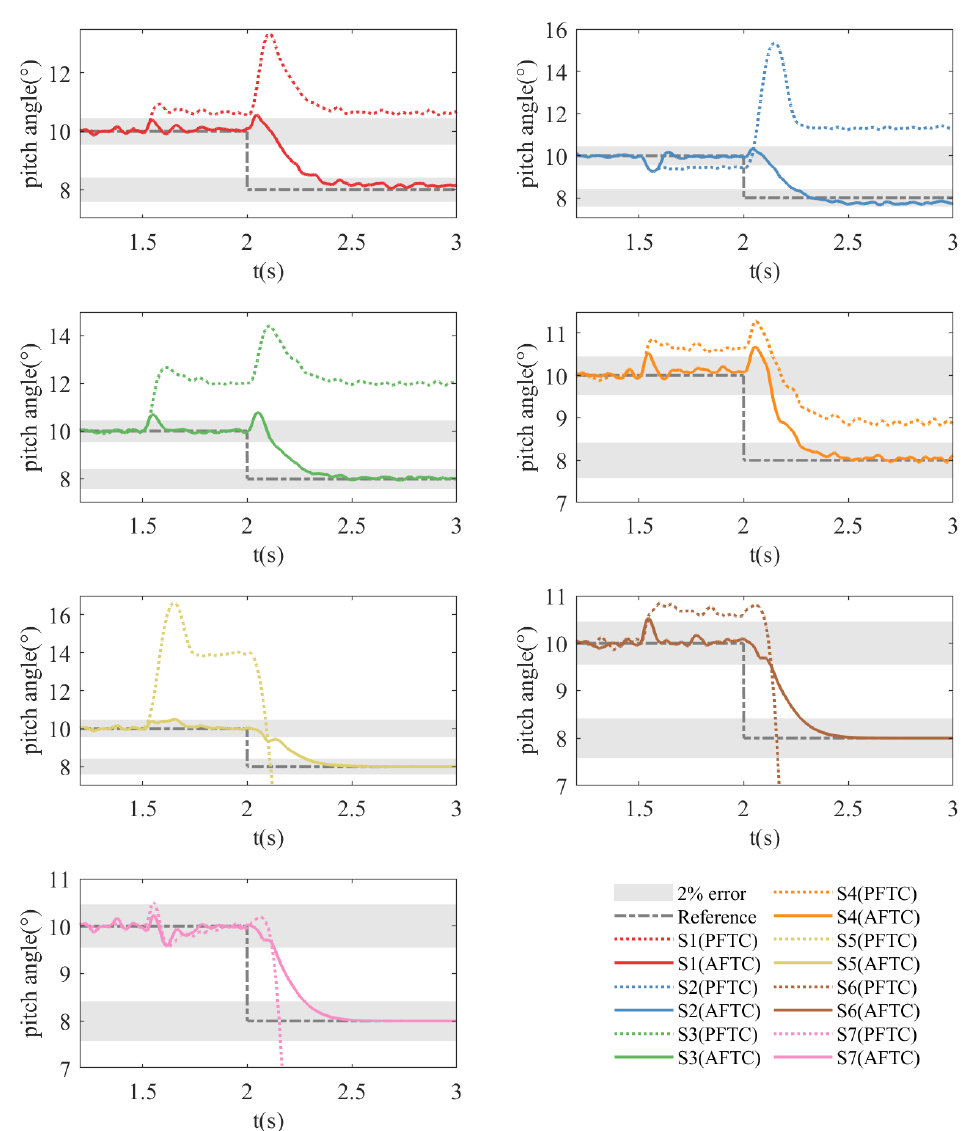
Figure 13. Comparative results of the proposed ADRC-based active fault-tolerant control for QUAV in various